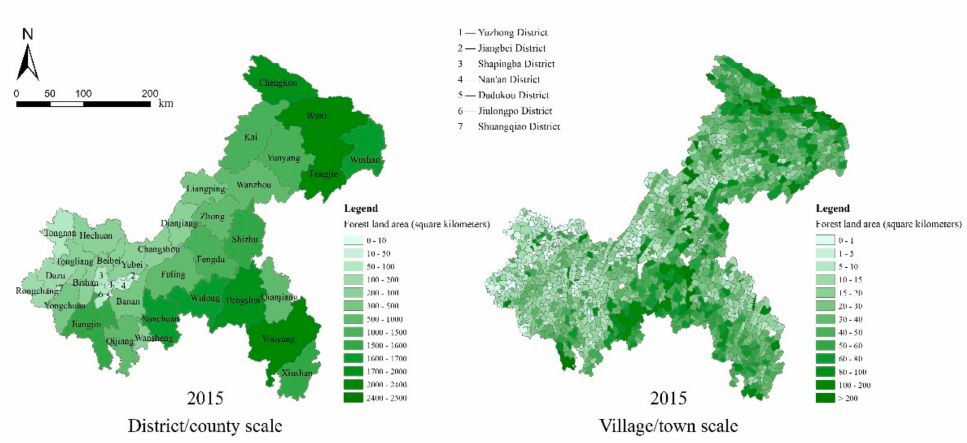
Figure 4. Spatial patterns of forest land area rate at district/county ( left ) and village/town ( right ) level; Source: edited by